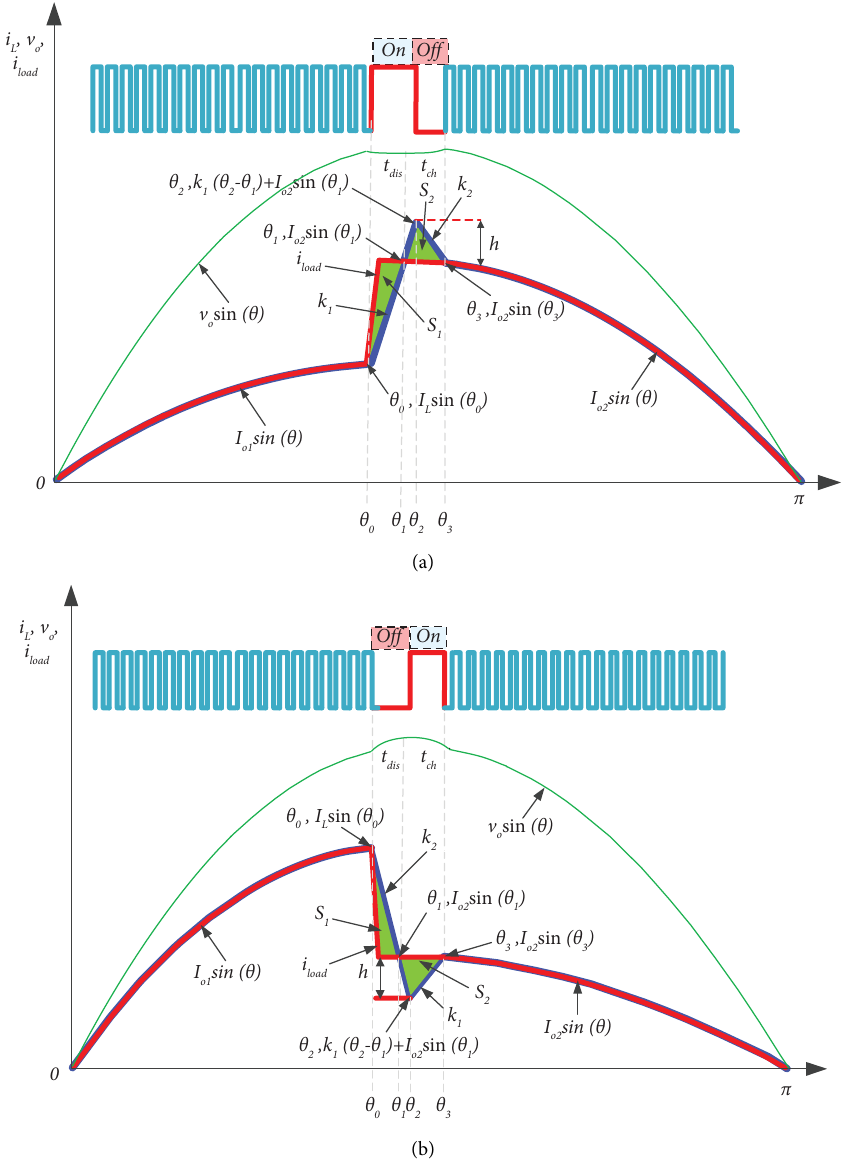
Figure 4: Te transient response waveform with the optimal trajectory controller in response to load changes. (a) Positive step change. (b) Negative step